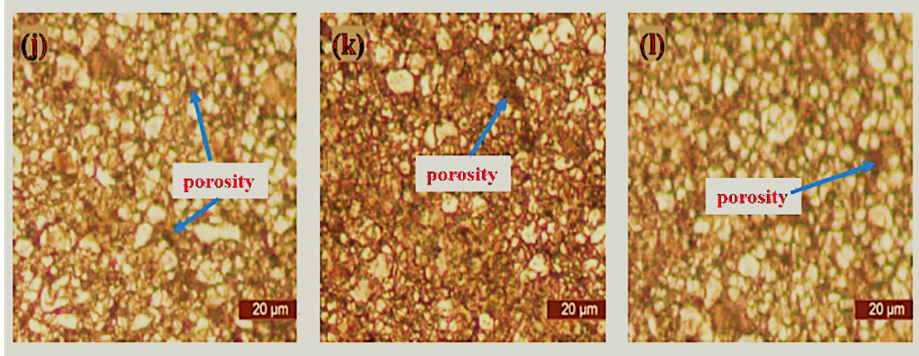
Figure 10. Microstructure of sintered samples ( f ) S6, ( g ) S7, ( h ) S8, and ( i ) S9.